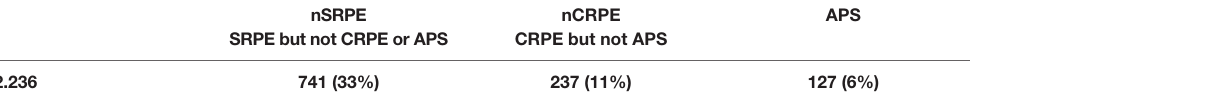
TABlE 3 | Association of mutually exclusive categories of non-confirmed self-reported psychotic experiences (nSRPE), non-APS clinically relevant PE (nCRPE), and attenuated psychotic symptoms (APS) and demographic and clinical variables. nSRPE SRPE but not CRPE or APS